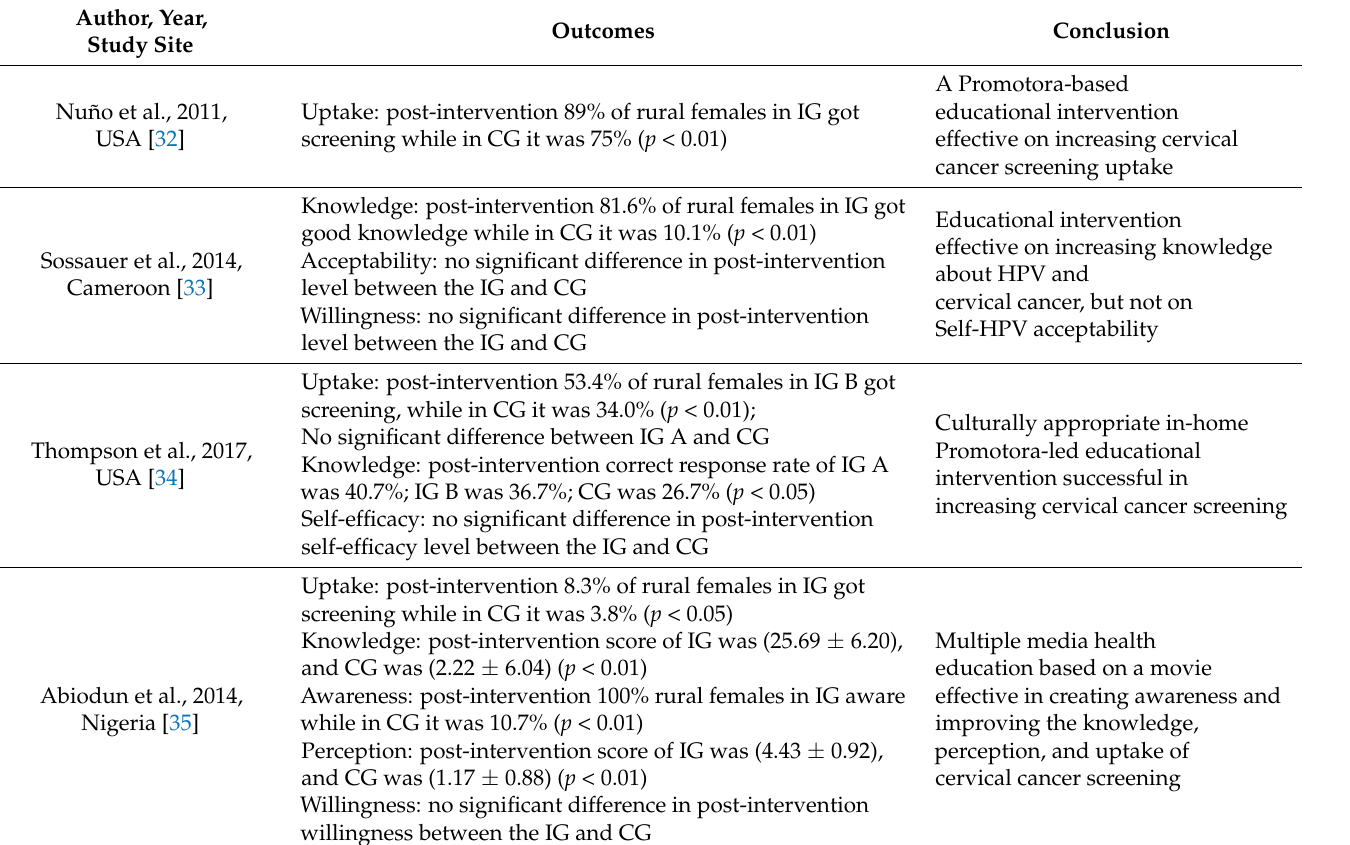
Table 7. Studies’ results and